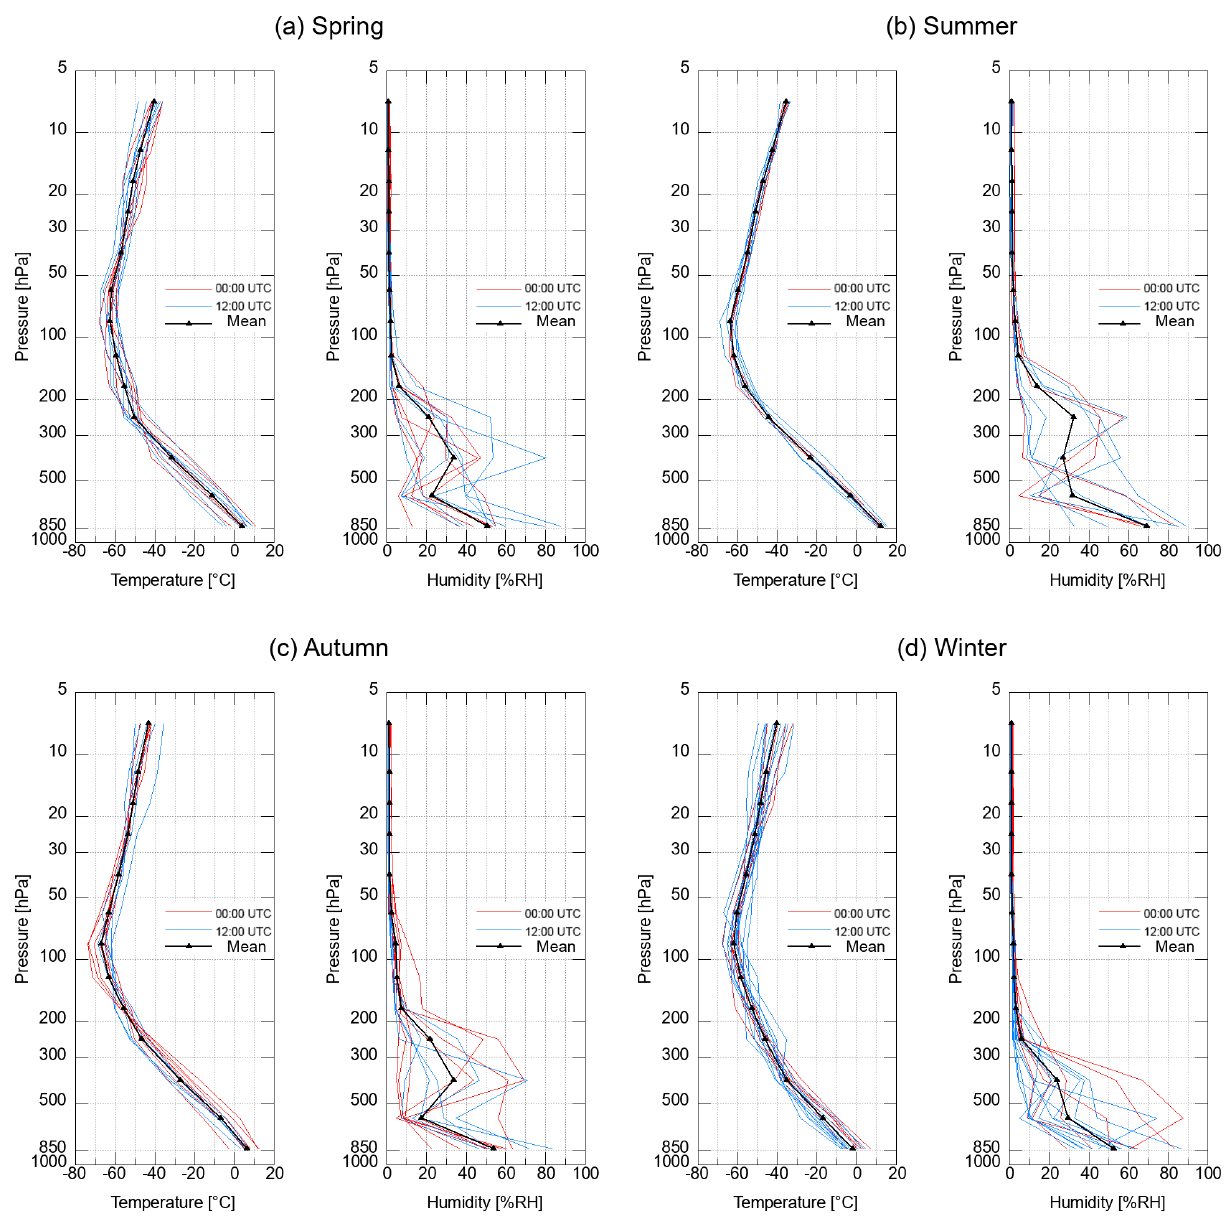
Figure 9. Seasonal profiles of temperature and RH from RS-11G. Red and blue lines show daytime and nighttime observations, respectively, and black lines show means for all